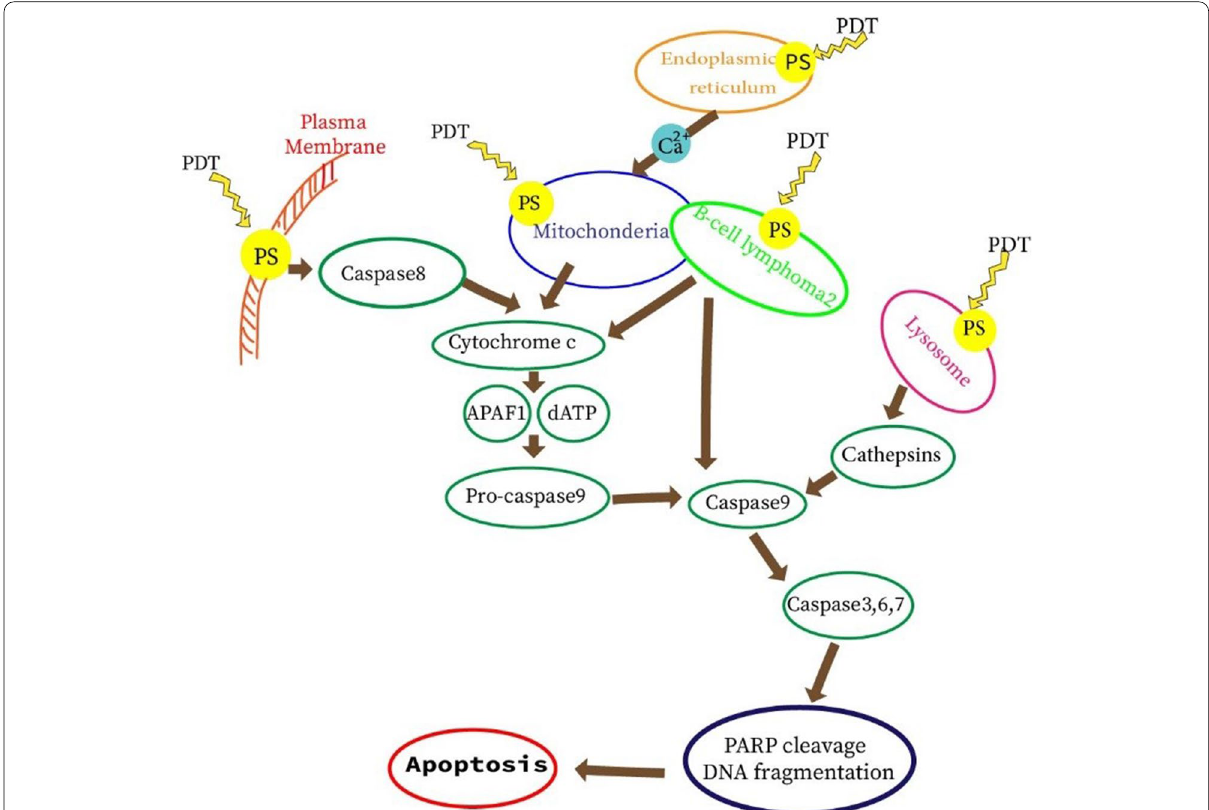
Fig. 3 Cellular signaling pathways based on photosensitizer (PS) localization and apoptosis induction upon